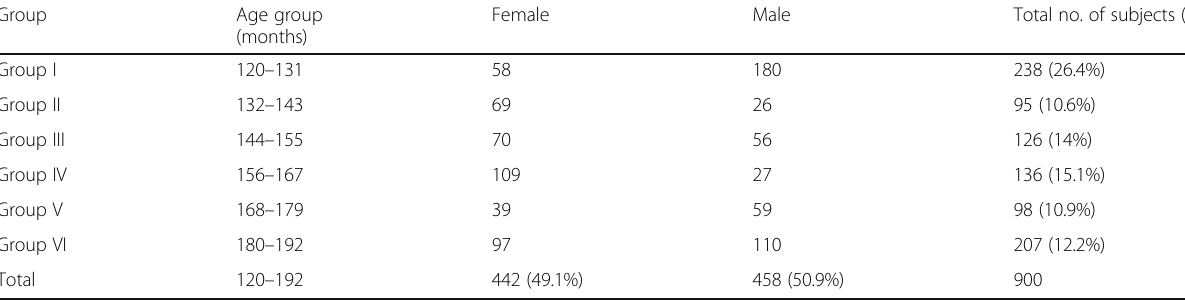
Table 1 Age and gender distribution of the subjects included in the study